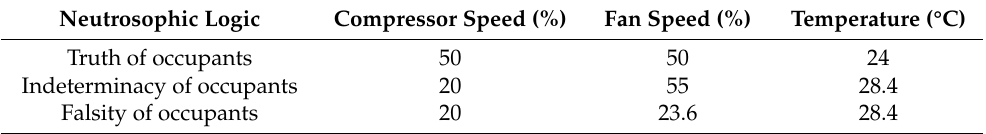
Table 5. Findings from neutrosophic